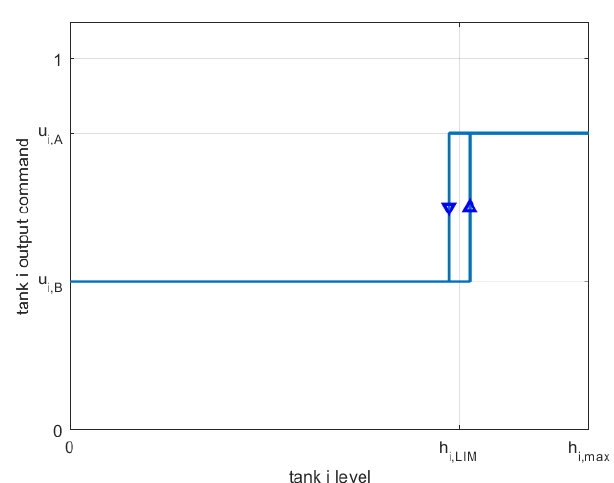
Figure 13. Strategy #3 controls depending on the liquid level in the tanks.